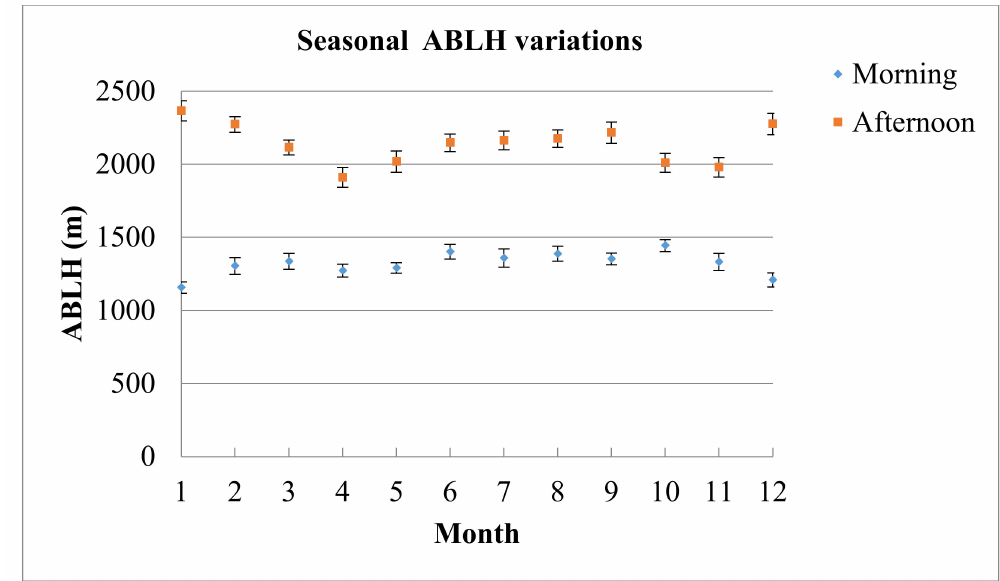
Figure 3. Mean ABLH in the morning and afternoon for months 1–12 (Jan–Dec). The mean was computed using data from the fourteen locations described in Table A1. The error bars show the standard error of the